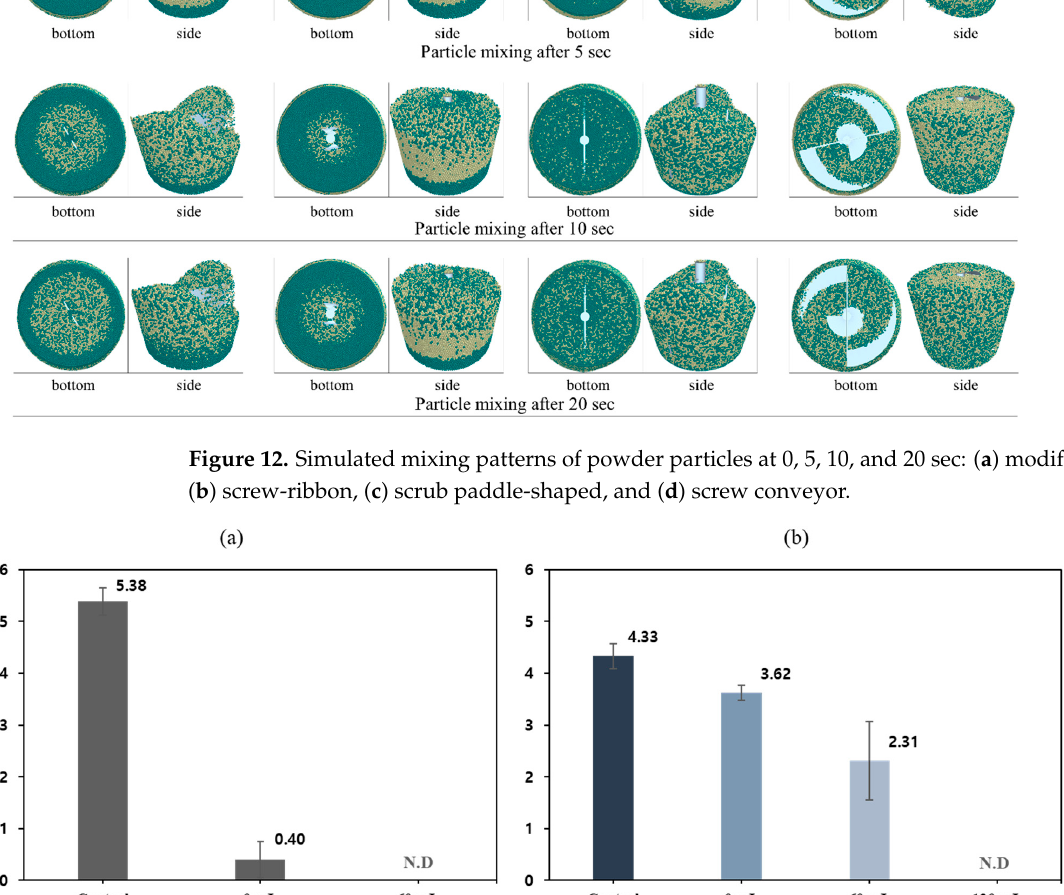
Figure 14. The change of water activity of the ( a ) inoculated and ( b ) un-inoculated powder by vacuum-steam treatments (0, 60, and 120 mL). Figure 15. Change in water activity at vacuum heating time (0 to 240 min). 3.4. Color Change Assessment of Treated Powder Table 3 shows the CIE values of sprout barley powder treated by each experimental condition. The initial values of the chromatic parameters of the sprout barley powder used in the experiment were 𝐿 ∗ = 50.93 ± 3.26, 𝑎 ∗ = − 7.51 ± 1.75, and 𝑏 ∗ = 32.66 ± 2.16. The inoculated powder heated without steam spray had L* , a* , and b* values of 47.95, − 5.94, and 32.47, respectively, and the total change ∆ E was 3.37. The L* , a* , and b* values of the